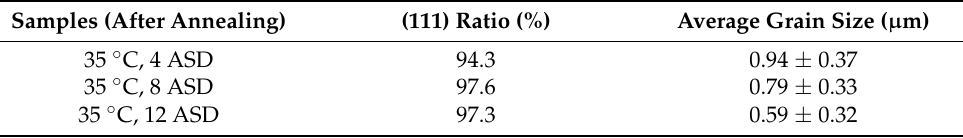
Table 4. Degree of (111) orientation and grain size of the nt-Cu films deposited at 35 ◦ C and annealed at 200 ◦ C for 10